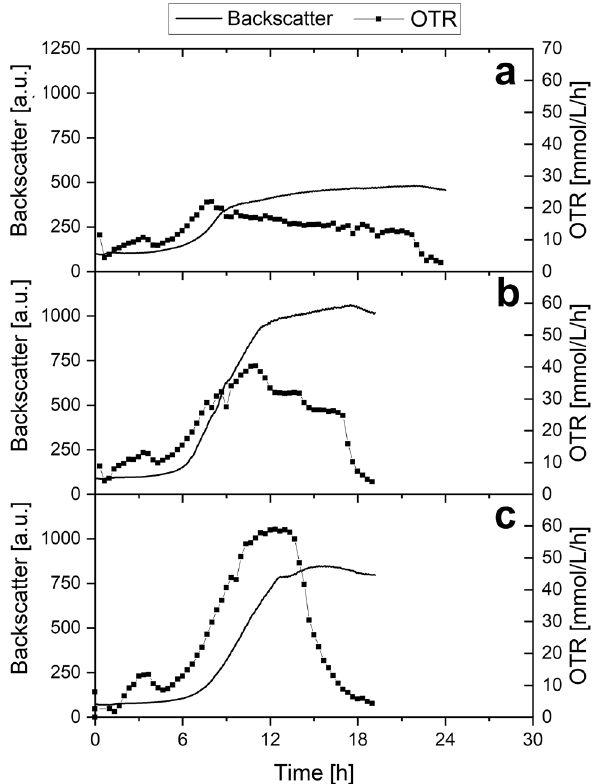
Figure 5. Oxygen transfer rate (OTR) and backscatter of shake flask cultivations of S. pasteurii in different media. Backscatter data was generated using the Cell Growth Quantifier system and cannot be compared to backscatter data from microplate cultivation. Cultivation was carried out in (a) chemically defined medium, (b) improved chemically defined medium (c) improved YE medium. Cells were harvested when the OTR decreased to near 0 mmol/L/h. Average pH of all cultures: 9.26 ± 0.09. Culture conditions: 250 mL shake flasks, filling volume 10 mL, shaking frequency 300 rpm, shaking diameter 50 mm and temperature 30 the experimental setup, no biological replicates were obtained simultaneously. However, the experiment was repeated with the same results (see Supplementary Figure